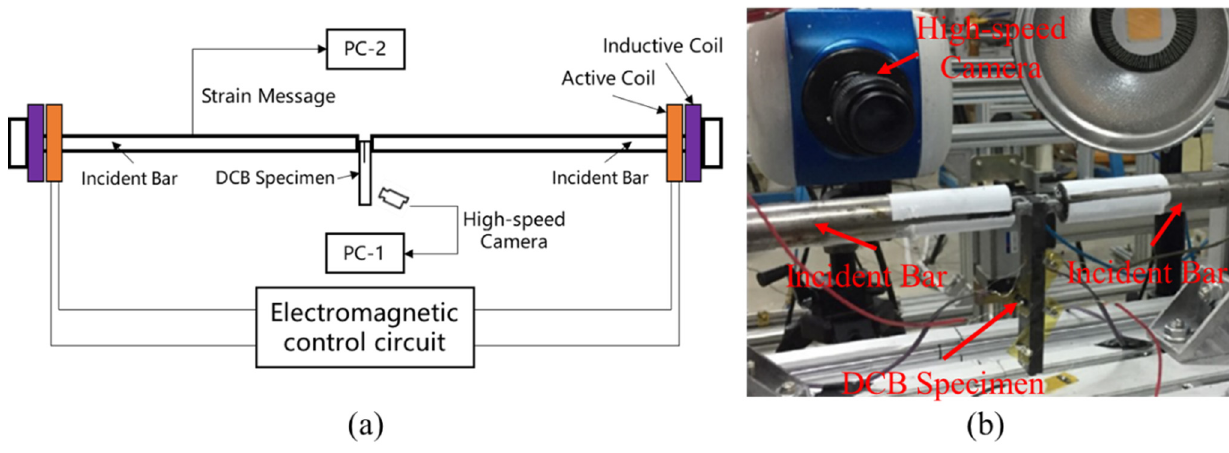
Figure 1. The electromagnetic Hopkinson bar system used to conduct dynamic double cantilever beam (DCB) test ( a ) schematic diagram ( b ) testing bench.